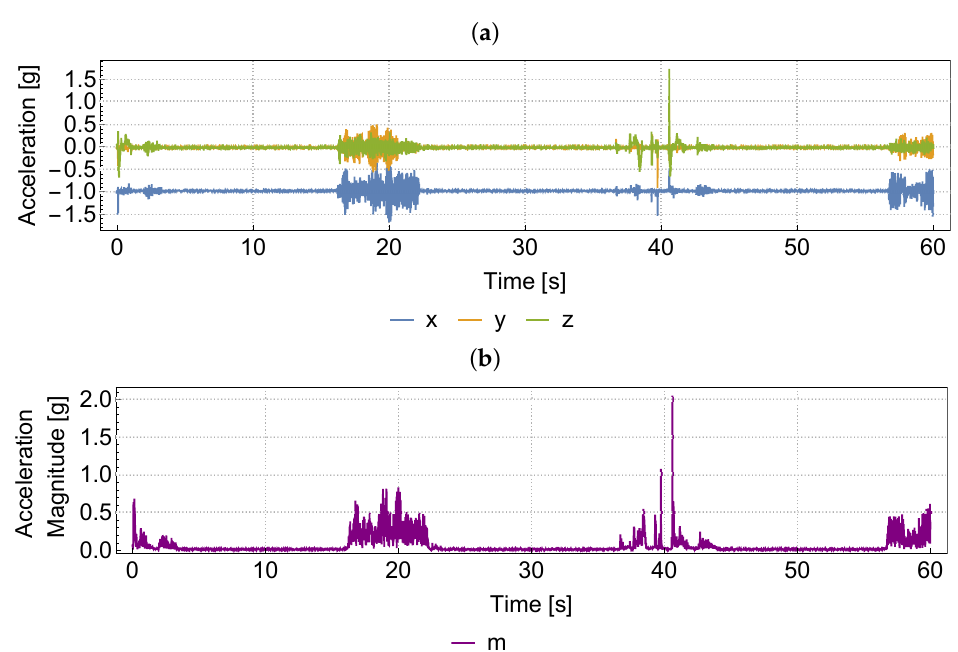
Figure 3. Depiction of the pre-processing step: ( a ) original 3D data set; ( b ) transformed 1D time series acceleration magnitude M ( · ,100 )